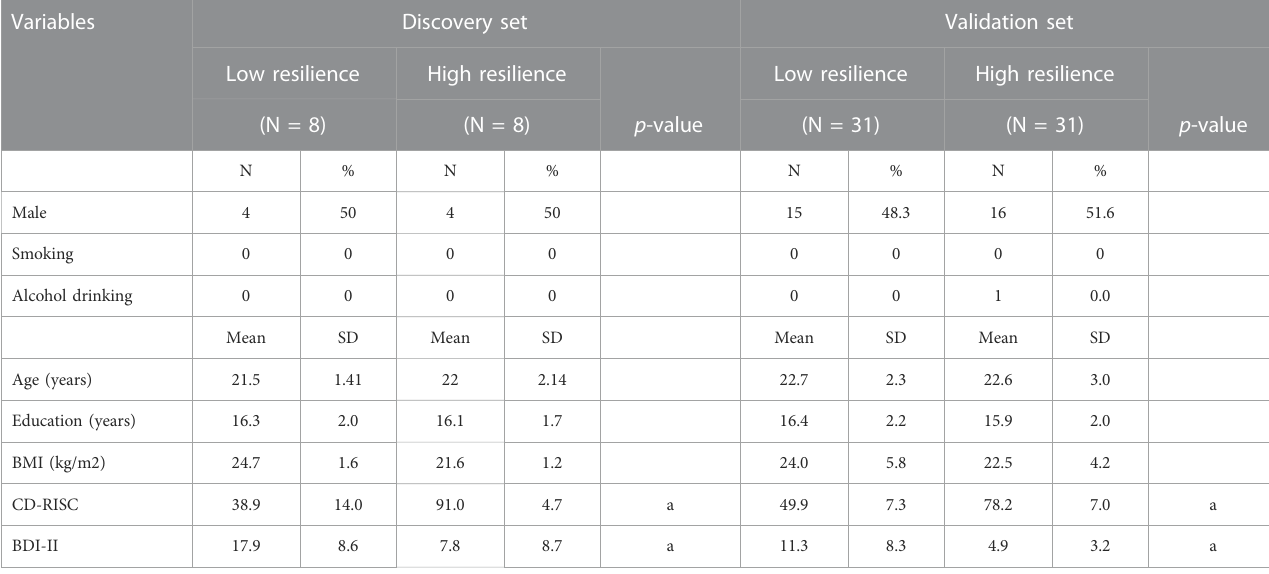
TABLE 1 Demographics and clinical characteristics of LR and HR groups.